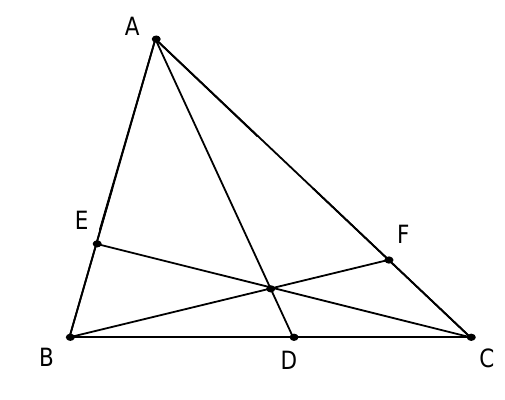
Figure 4. Ceva's theorem